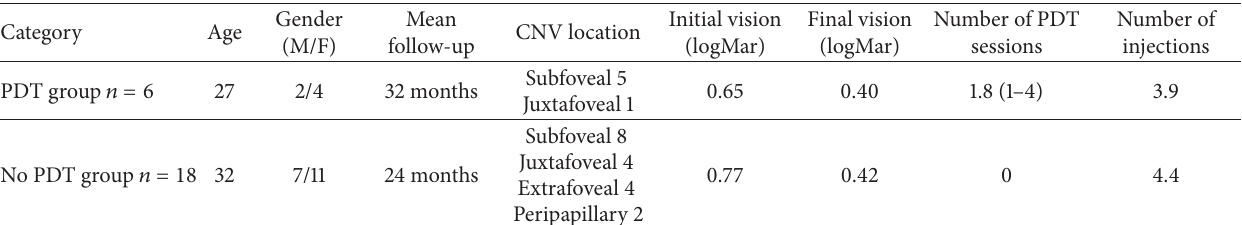
Table 3: Summary profile comparing patients who underwent PDT plus anti-VEGF to patients who had anti-VEGF therapy alone (excluding chronic cases of CNV) at the 6-month follow-up ∗